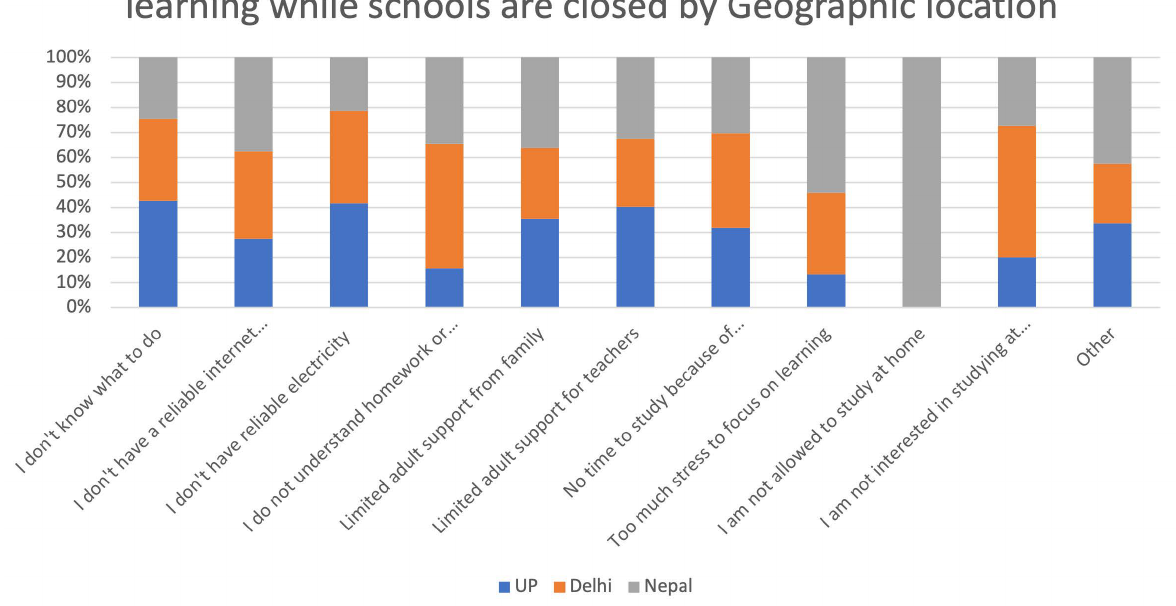
Figure 2. Challenges faced while schools are closed due to the pandemic by geographic location.